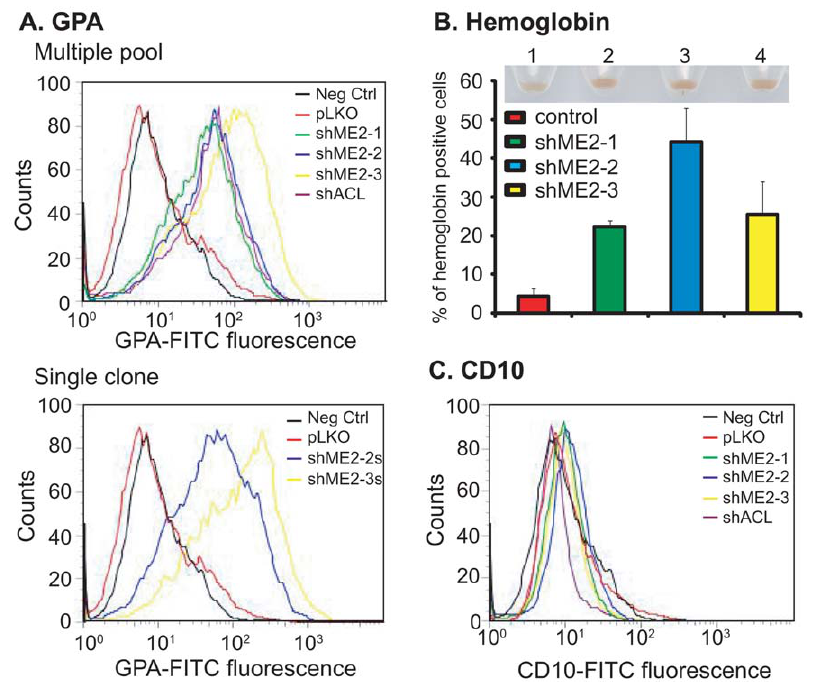
Figure 2. Stable knockdown of endogenous ME2 levels in K562 cells induces erythroid differentiation. A: Expression levels of the erythroid marker glycophorin A on the surface of control (pLKO) and ME2 knockdown cells (shME2-1, shME2-2 and shME2-3) were compared using a mouse FITC-conjugated anti-human glycophorin A antibody. As a negative control (Neg Ctrl), cells were incubated with FITC-conjugated control IgG. As a positive control, K562 cells were transduced with ATP citrate lyase (ACL) shRNA lentiviral particles (ACL inhibition is known to cause erythroid differentiation in K562 cells – referenced in the text), and incubated with mouse FITC-conjugated anti-human glycophorin A antibody. The control clone was generated by stable transduction of control pLKO vector, while clones shME2-1, shME2-2 and shME2-3 were generated using the pLKO- ME2 shRNA lentivirus. Data are representative of three independent experiments. B: The percentage of hemoglobin-expressing cells in control (pLKO) and ME2 knockdown (shME2-1, shME2-2 and shME2-3) cell populations was determined by benzedrine staining. Plotted is the mean 6 SD